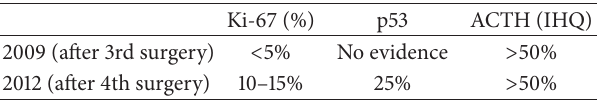
Table 2: Tumor markers comparison between third and fourth surgeries.